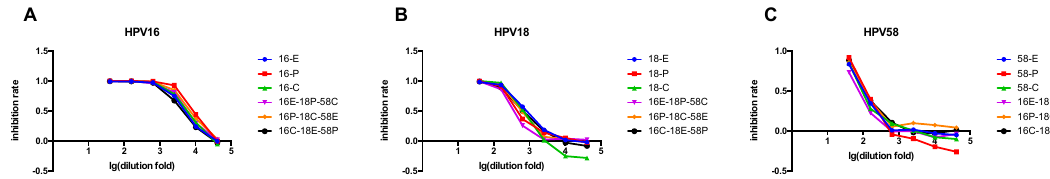
Figure 5. Comparison of single- and three-color PBNAs against HPV16, HPV18, and HPV58. ( A ) Comparison of single- and three-color PBNAs for HPV16; ( B ) Comparison of single- and three-color PBNAs for HPV18; ( C ) Comparison of single- and three-color PBNAs for HPV58. 16-E: HPV16 pseudovirion packaged with the EGFP reporter gene; 16-R: HPV16 pseudovirion packaged with the RFP reporter gene; 16-C: HPV16 pseudovirion packaged with the CFP reporter gene; 16E-18R-58C: HPV16 EGFP + HPV18 RFP + HPV CFP; 16R-18C-58E: HPV16 RFP + HPV18 CFP + HPV58 EGFP; 16C-18E-58R: HPV16 CFP + HPV18 RFP + HPV58 EGFP. The sample tested contained mixed sera from mice immunized with a candidate nonavalent HPV vaccine.